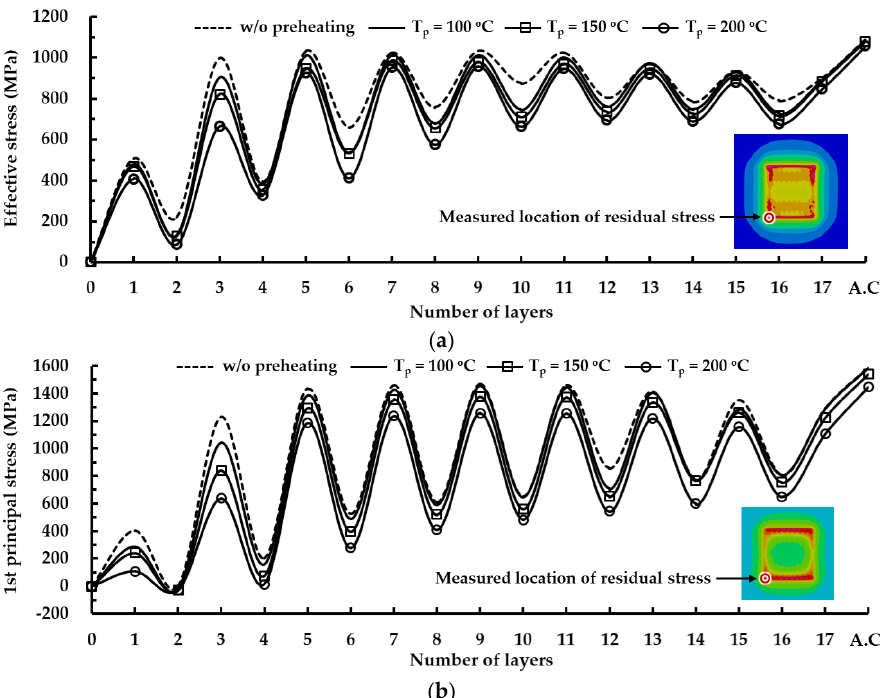
Figure 17. Histories of residual stresses at the location of maximum stress for different preheating temperatures: ( a ) effective stress; ( b ) first principal stress.